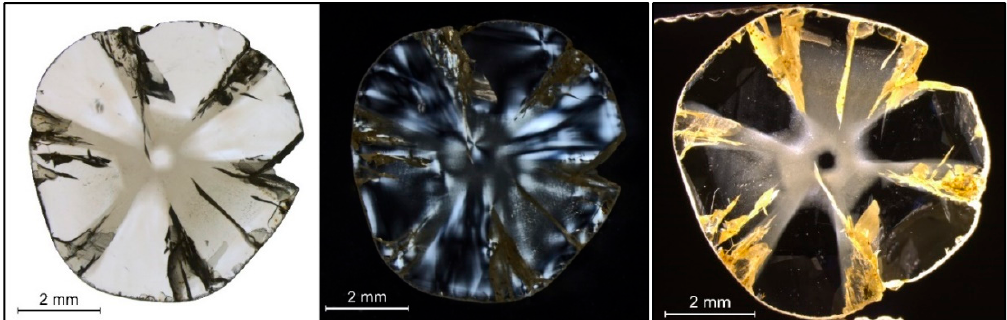
Figure 12. A hydrogen-rich light yellow-brown diamond (TH 2.618), not colored by deformation- related defects, but by nickel-nitrogen-(hydrogen?)-related defects in immersion ( left ) and under crossed polarizing filters ( right ). Very faint parallel color zoning can be seen, the strain in the diamond is virtually undetectable using crossed polarizers.